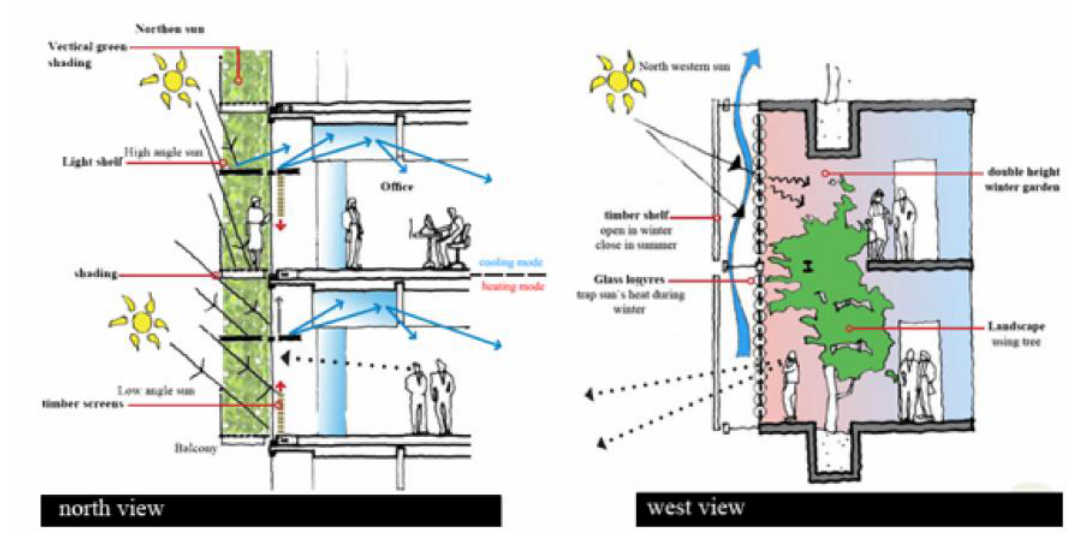
buildings, the author based on 2 (Tan,